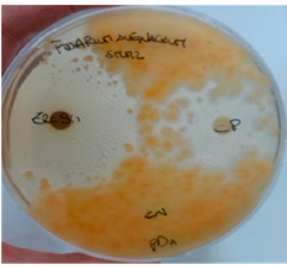
Figure 2. Example of the antifungal activity of the chloroform–methanol Zr-b extract on Fusarium avenaceum growth, determined by the agar diffusion method. The inhibition zone on the left is obtained with the chloroform–methanol Zr-b extract, and on the right with Tioconazole. The results of in vitro assays indicate that all the Zr-b extracts exhibited a clear antioomycete and antifungal activity, with the formation of wide inhibition zones against Fusarium avenaceum and Aphanomyces astaci , although the widest area of inhibition was obtained with the chloroform–methanol extract. Tioconazole (TCZ) (1.4 mg/disc), used as a positive control, exerted the expected antifungal activity against Fusarium avenaceum with an inhibition zone of 40.1 ± 7.2 mm, but also induced an